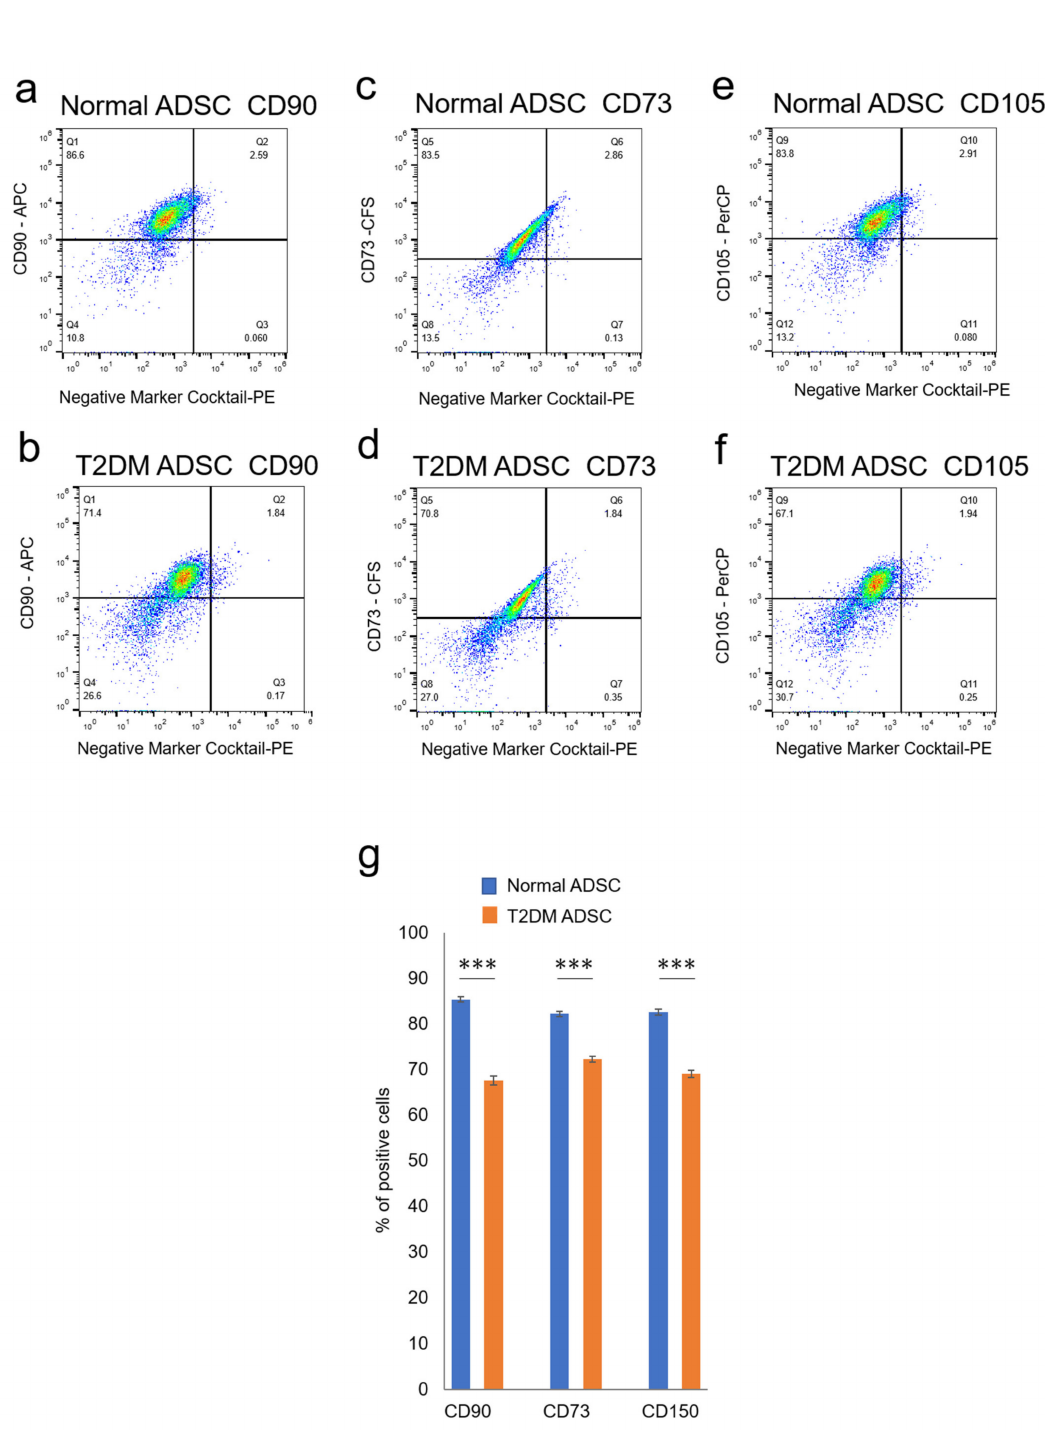
Figure 3. Evaluation of the stemness of ADSCs derived from patients with type II diabetes mellitus. The variation in stem cell rates of normal and T2DM ADSCs was evaluated by flowcytometry. ( a ) The distribution of the stem cell marker, CD90, in the normal ADSCs is shown. ( b ) The distribution of the stem cell marker, CD90, in the T2DM ADSCs is shown. ( c ) The distribution of the stem cell marker, CD73, in the normal ADSCs is shown. ( d ) The distribution of the stem cell marker, CD73, in the T2DM ADSCs is shown. ( e ) The distribution of the stem cell marker, CD105, in the normal ADSCs is shown. ( f ) The distribution of the stem cell marker, CD105, in the T2DM ADSCs is shown. The stem cell marker-positive cell rates were calculated. ( g ) The stem cell marker-positive cell rates in terms of mean ± SE are shown. The number of samples was n = 3. The percentage of CD maker-positive cells was evaluated three times independently. The unpaired t -test was used to test for statistical significance. For CD90, *** p = 0.0002. For CD73, *** p = 0.0006. For CD105, *** p =